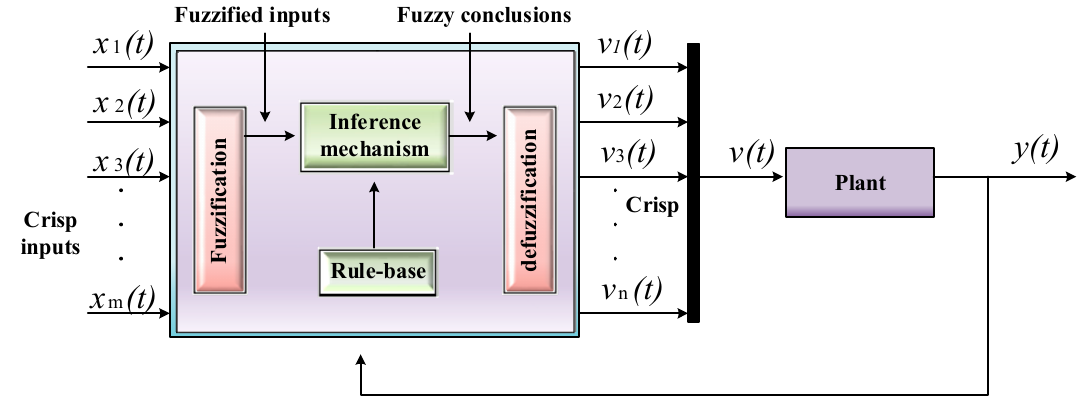
Figure 4. Fuzzy controller architecture to controlled plant.